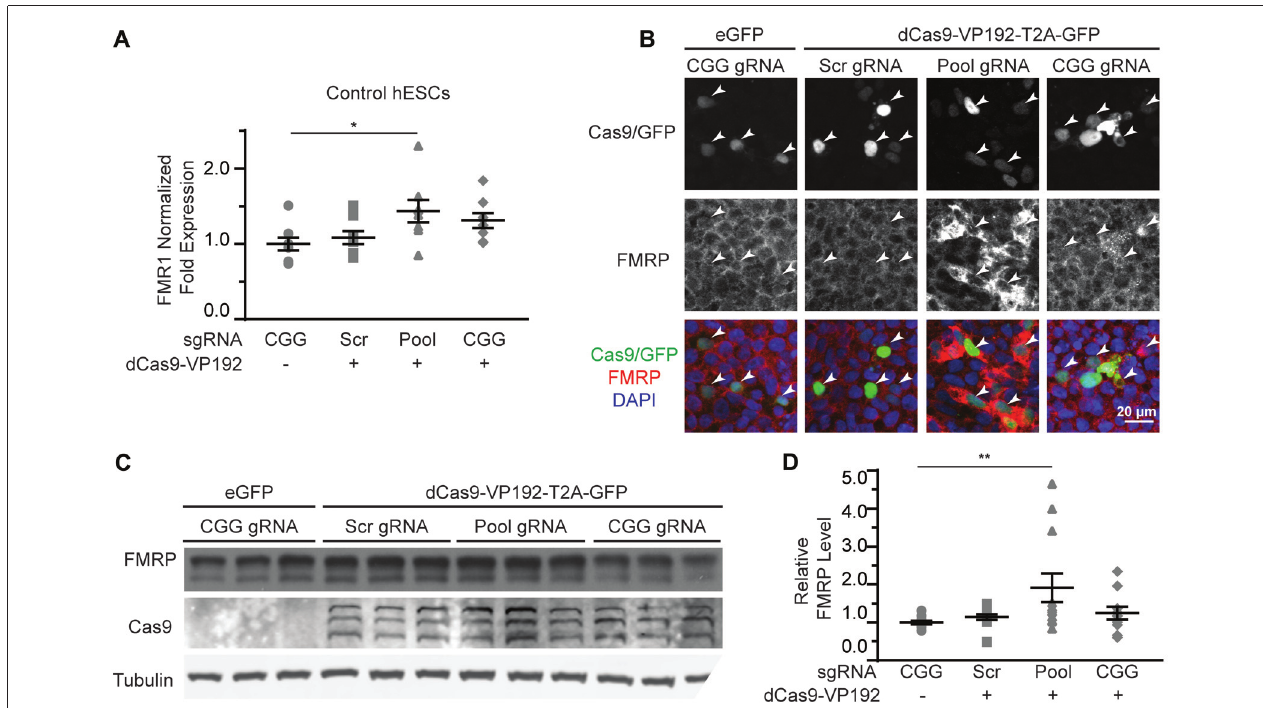
FIGURE 5 | CRISPR-mediated activation enhances FMR1 transcription and FMRP protein abundance in control hESCs. (A) Relative FMR1 mRNA expression in control (UM4-6) hESCs transfected with a control plasmid or dCas9-VP192 and the indicated gRNAs ( ∗ p < 0.05, Kruskal-Wallis one-way ANOVA with Dunn’s multiple comparison test). (B) Images of control hESCs transfected with eGFP or dCas9-VP192 and gRNAs, as indicated. Single channel and merged images are shown with Cas9/GFP (green), FMRP (red) and DAPI (blue). Arrowheads indicate transfected cells. Scale bar represent 20 µ m. (C) Western blots showing triplicate samples of control hESCs transfected and immunoblotted as indicated. (D) Quantification of western blots from control hESCs transfected as indicated. Data are shown as FMRP levels normalized to tubulin and relative to the control plasmid ( ∗∗ indicates p = 0.0061 by Kruskal-Wallis one-way ANOVA with Dunn’s multiple comparison test). For all scatter plots, each data point represents an individual well. Data were obtained from three (A) or four (D) independent experiments. The mean with error bars (SEM) is shown for each